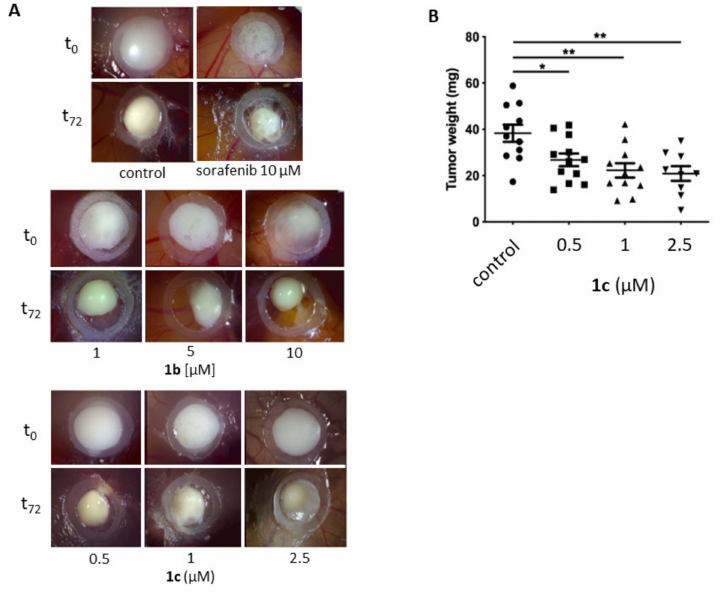
Figure 2. Suppression of hepatoma tumor growth in vivo. ( A ) Representative images of hepatoma tu- mor bearing CAMs at the beginning (t 0 ) and after 72 h (t 72 ) of treatment with 1b (middle panel) and 1c (lower panel). Growth of PBS- and sorafenib-treated tumors served as control and sorafenib-reference, respectively (upper panel), n = 2 experiments for 1b and n = 3 experiments for 1c . ( B ) Statistical analysis of the effects of 1c revealed a dose-dependent and significant decrease in tumor weight after 3 days of treatment. Box plot diagram indicates mean tumor weight ± SD for each